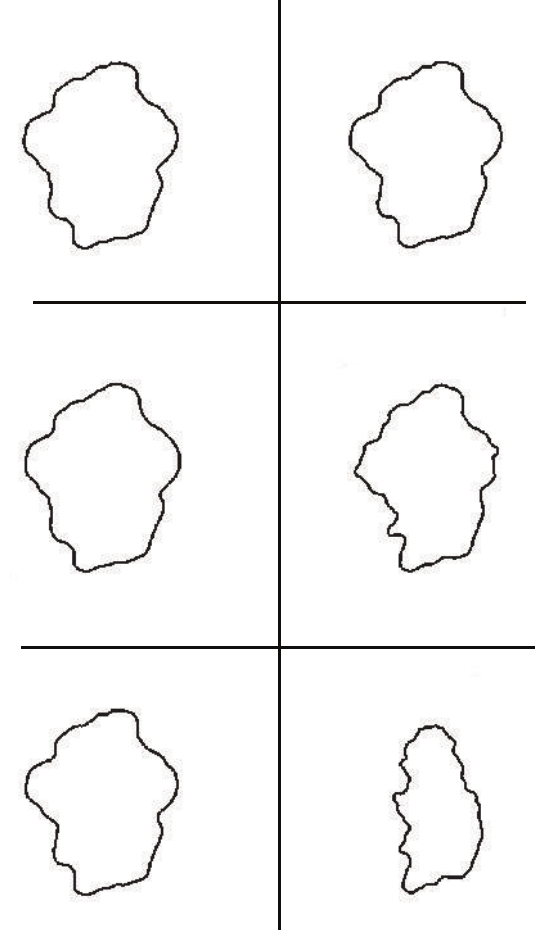
Figure 8: Test 2: Comparisons between segmentation results. On the left Algorithm I. On the right Algorithm SI. First row:, Δ τ I = 0 . 4, Δ τ SI = 0 . 16. Second row: Δ τ I = 0 . 04, Δ τ SI = 0 . 16. Third row: Δ